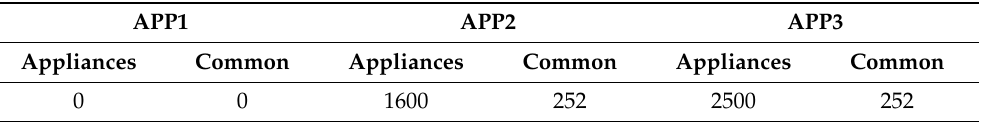
Table 6. Variants for the electricity demand (appliances and common areas) in [kWh/(a flat)]. APP1 APP2 APP3 Appliances Common Appliances Common Appliances